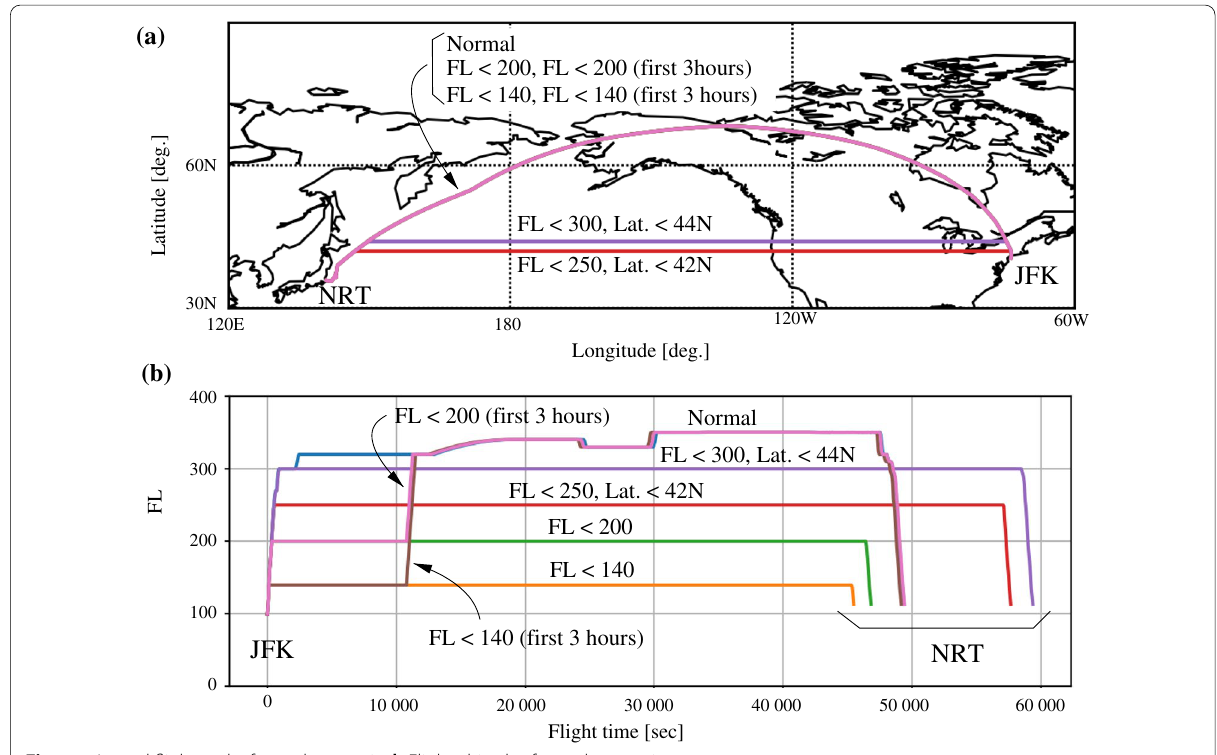
Fig. 5 a Lateral flight paths for each scenario. b Flight altitudes for each scenario